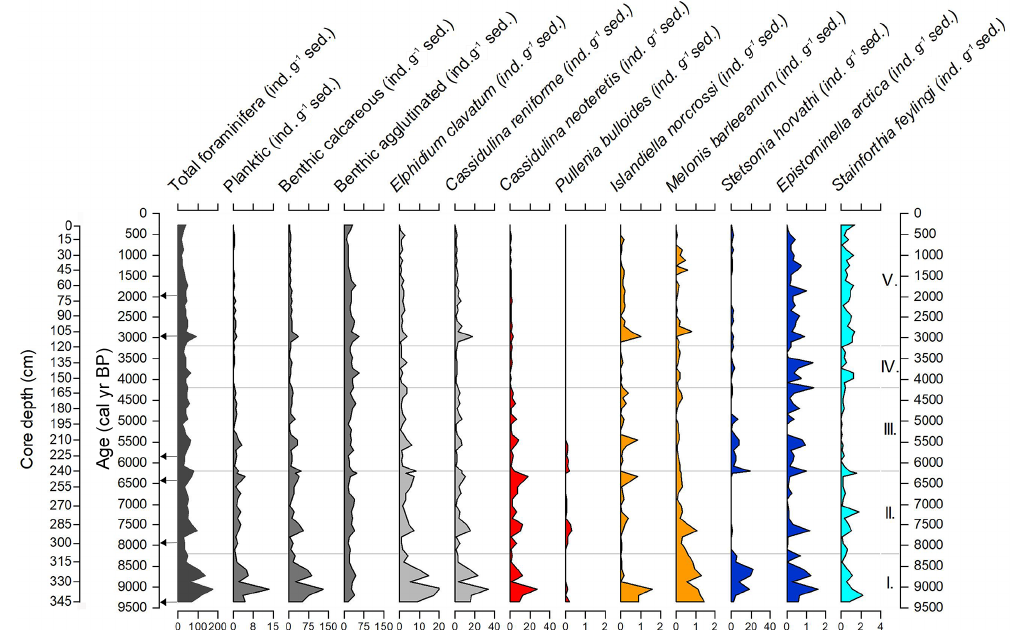
Figure A4. Foraminiferal concentrations showing the concentrations of nine selected calcareous benthic species versus calibrated age along sediment core DA17-NG-ST07-73G. The depicted species were chosen in order to show changes in the environment. Red represents species that indicate warm Atlantic Water inflow, orange represents species that indicate in the Arctic recirculated chilled Atlantic Water influence, dark blue represents Arctic Water species that are commonly found in connection to Polar Water and often live beneath perennial or near- perennial sea ice, and light blue represents a species that indicates sea ice. Ecozones (I–V) are shown on the right side of the figure. Black arrows next to the left primary y axis (age) mark radiocarbon dates. Note that the x axes have different scalings.